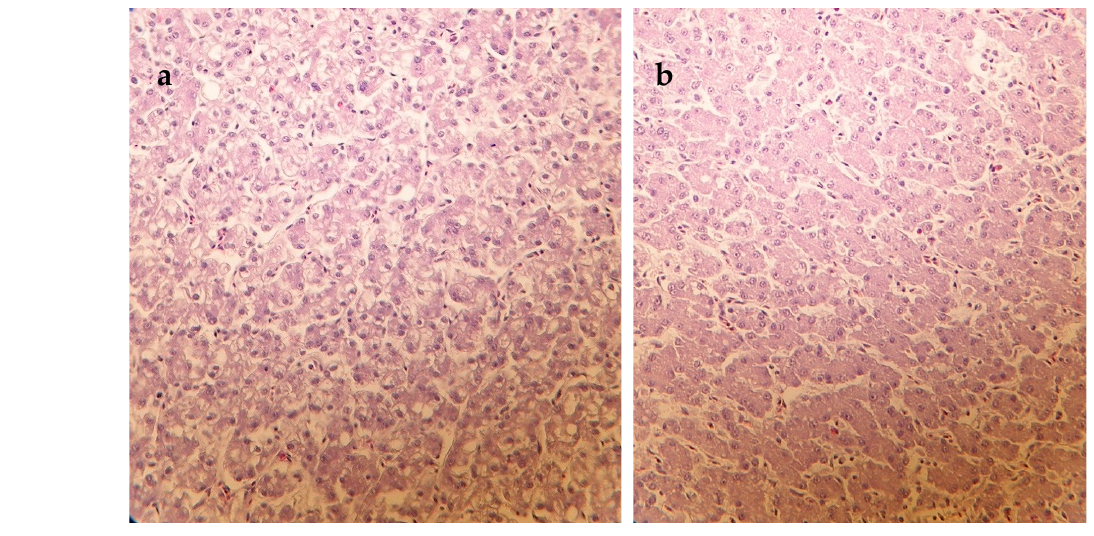
Figure 2. Hematoxylin and eosin ‐ stained sections of the bursa of Fabricius of ducks ( a ) Bursa of Fabricius section of a duck fed mycotoxin contaminated control diet showing mildly decreased lym ‐ phocyte counts (day 14), 200× magnification; ( b ) Bursa of Fabricius section of a duck fed mycotoxin contaminated diet supplemented with milk thistle seed showing normal lymphocyte counts (day 14), 200× magnification. 4. Discussion In our study, the potential health ‐ protecting effect of milk thistle against mycotoxins was investigated in ducks fed corn ‐ based diets contaminated with DON and ZEN. The three main possible feed supplements, milk thistle seed, seed cake, and seed oil, were compared in one experiment with poultry for the first time. The sensitivity of ducks to various fusariotoxins may differ from that of broilers, lay ‐ ers, and turkeys. However, there are no different EU advisory limit concentrations or di ‐ etary guidance levels for fumonisins, T ‐ 2, DON, and ZEN for different poultry species. In our study, the measured dietary concentration of DON (4.9 mg/kg) and ZEN (0.66 mg/kg) in corn were lower than the maximum EU guidance values for cereals (DON: 8 mg/kg; ZEN: 2 mg/kg; Commission Recommendation 2016/1319/EC). The calculated dietary con ‐ centration of DON (3.43 and 3.72 mg/kg in the experimental starter and grower diets,